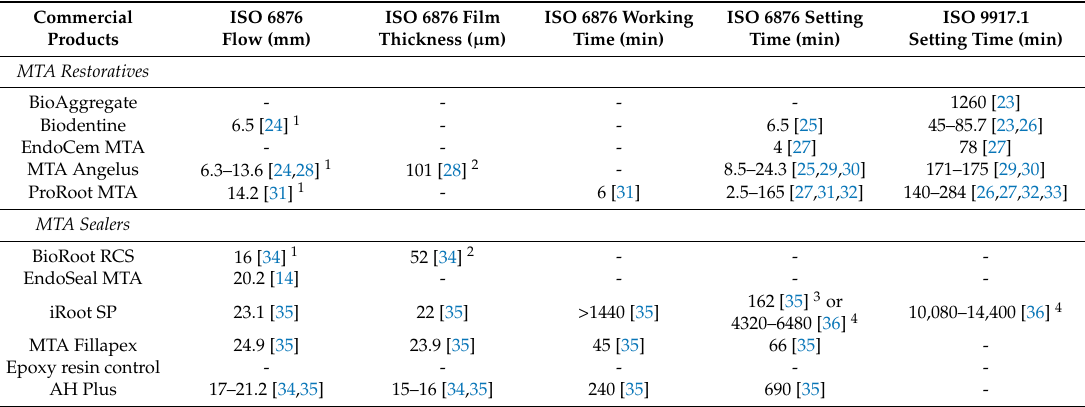
Table 3. Properties of MTA restoratives and sealers after